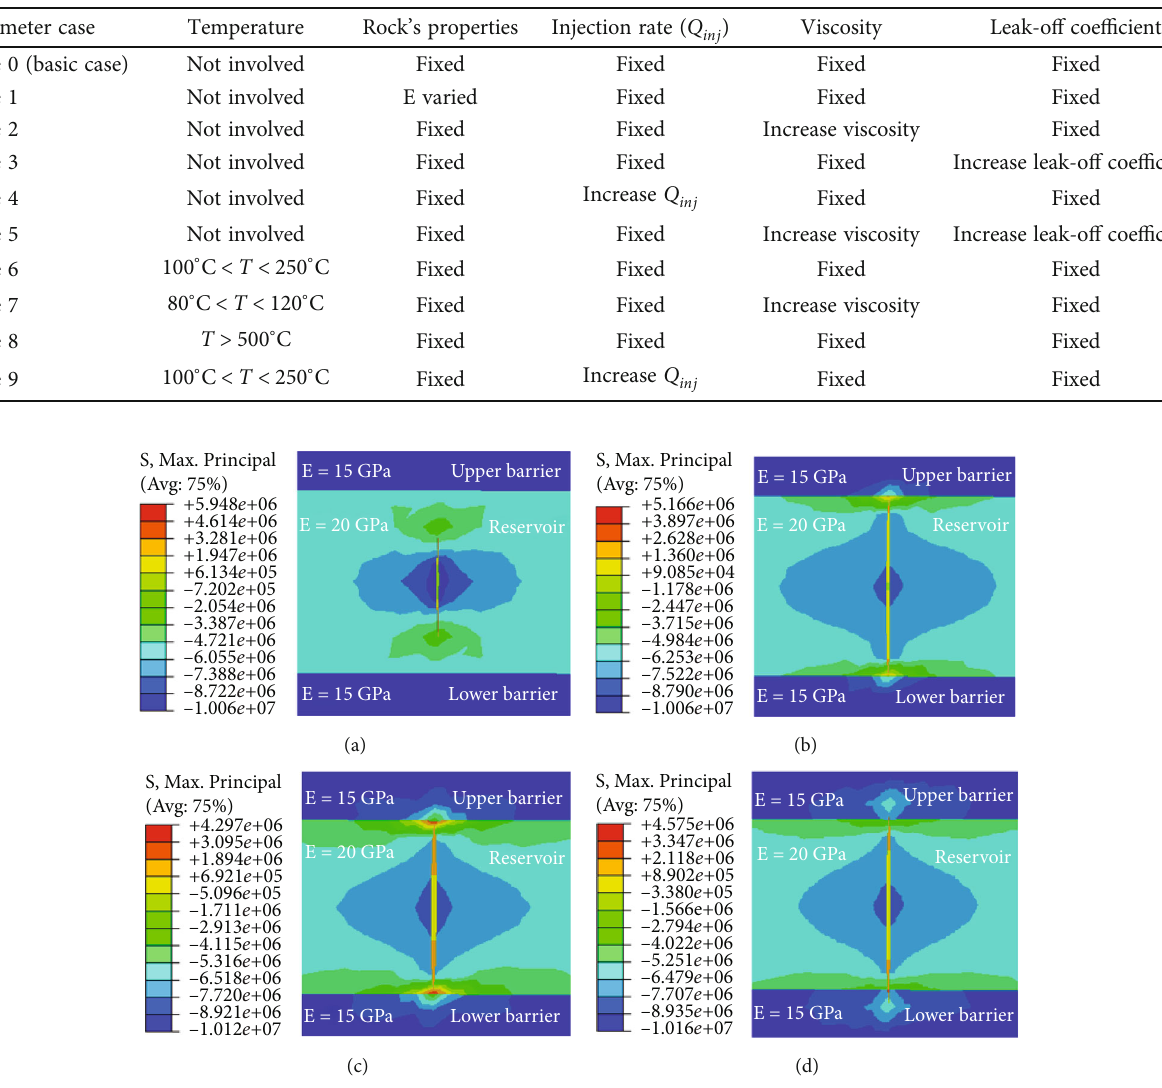
Table 3: Di ff erent cases studied in this paper.